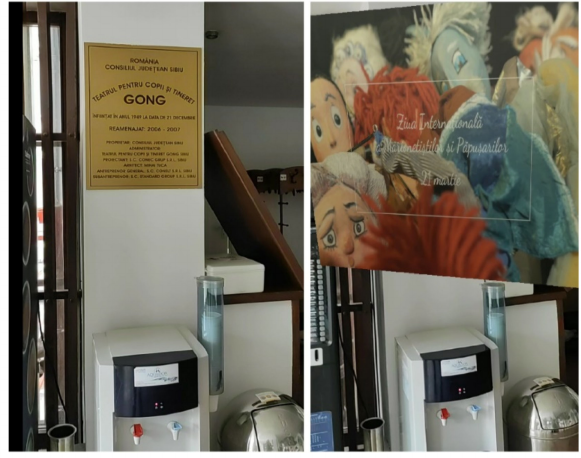
Figure 10. Piloting the augmented images functionality: a screen capture of the visitor’s phone, displaying the video stream acquired with the camera, before identifying the logo of the Gong Theatre ( left ), and a screen capture of the phone displaying the video promoting a cultural event superimposed on the video stream from the phone’s camera ( right ).